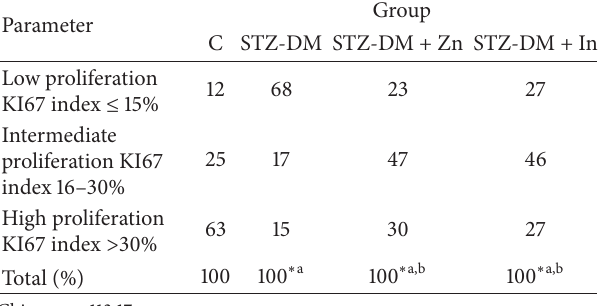
Table 6: Percentage frequency distribution of proliferation index in KI67 immunohistochemical stained myocardial sections in the different